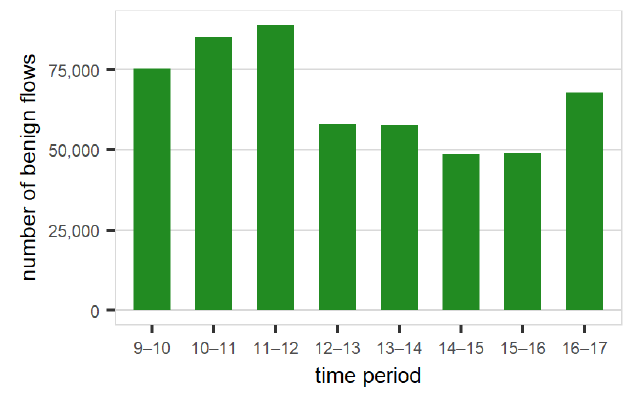
Figure 3. Benign flows per hour (all